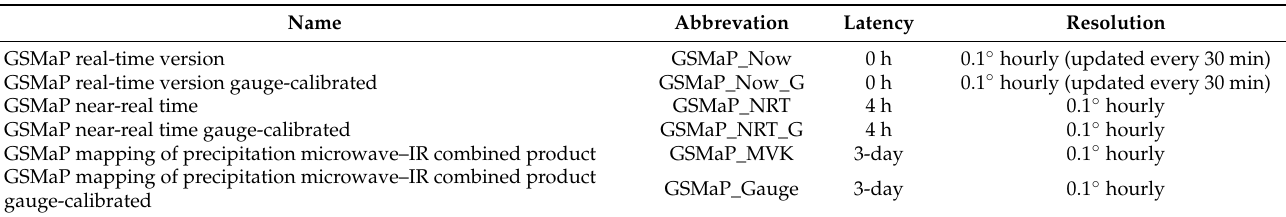
Table 1. Summary of GSMaP type used in this study.